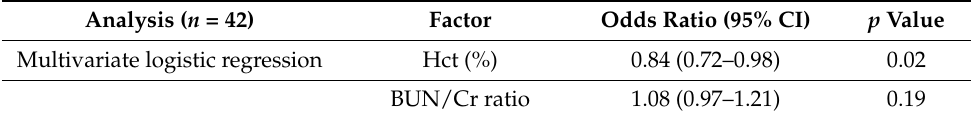
Table 5. Multivariate logistic regression analyses of risk factors associated with